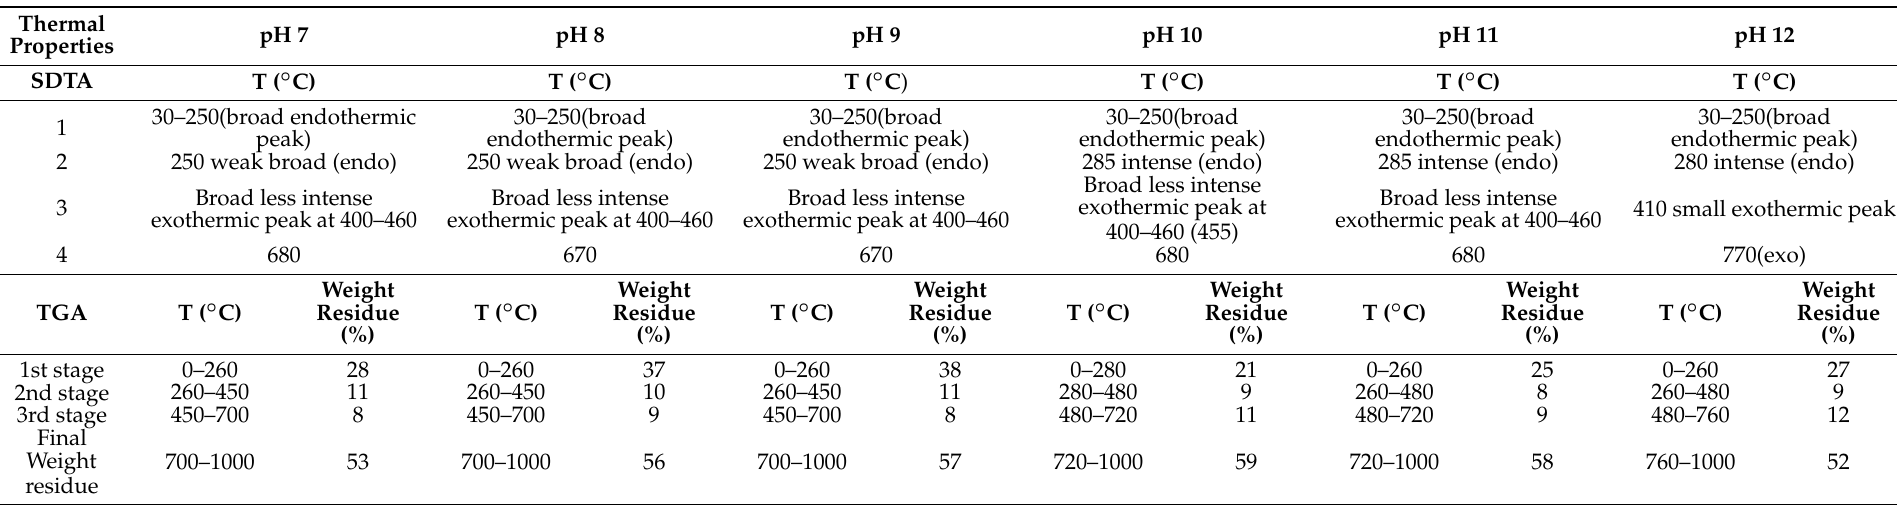
Table 2. Thermal properties of SDTA and TGA for PPVA-AlPO 4 nanocomposite for various